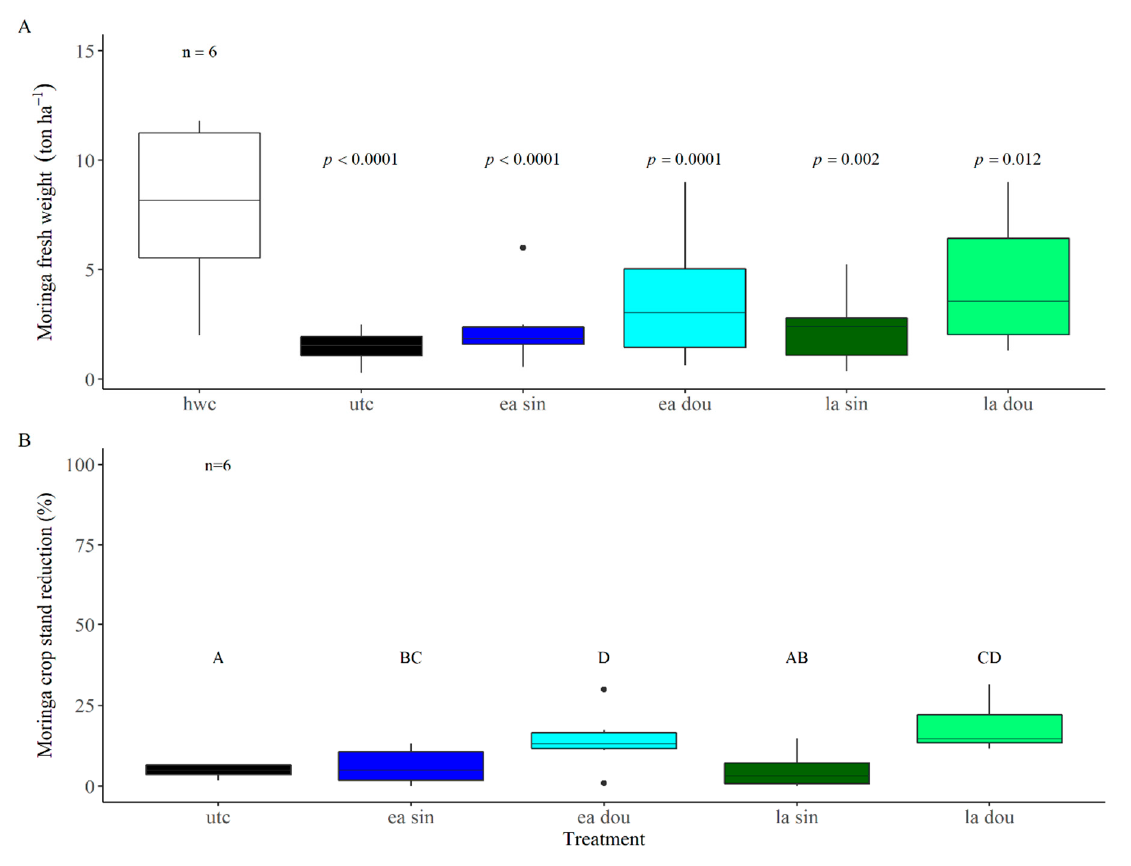
Figure 4. Effect of finger weeder treatments on the moringa. ( A ) Fresh weight. Differences between treatments were analyzed by the Dunnet test in comparison with the hand weeded control ( n = 6). (B ) Crop stand reduction. Different letters indicate significant differences according to the Tukey-HSD test ( n = 6). The treatments included: hand weeded (hwc), untreated control (utc), early single (ea sin), early double (ea dou), late single (la sin), and late double (la dou).